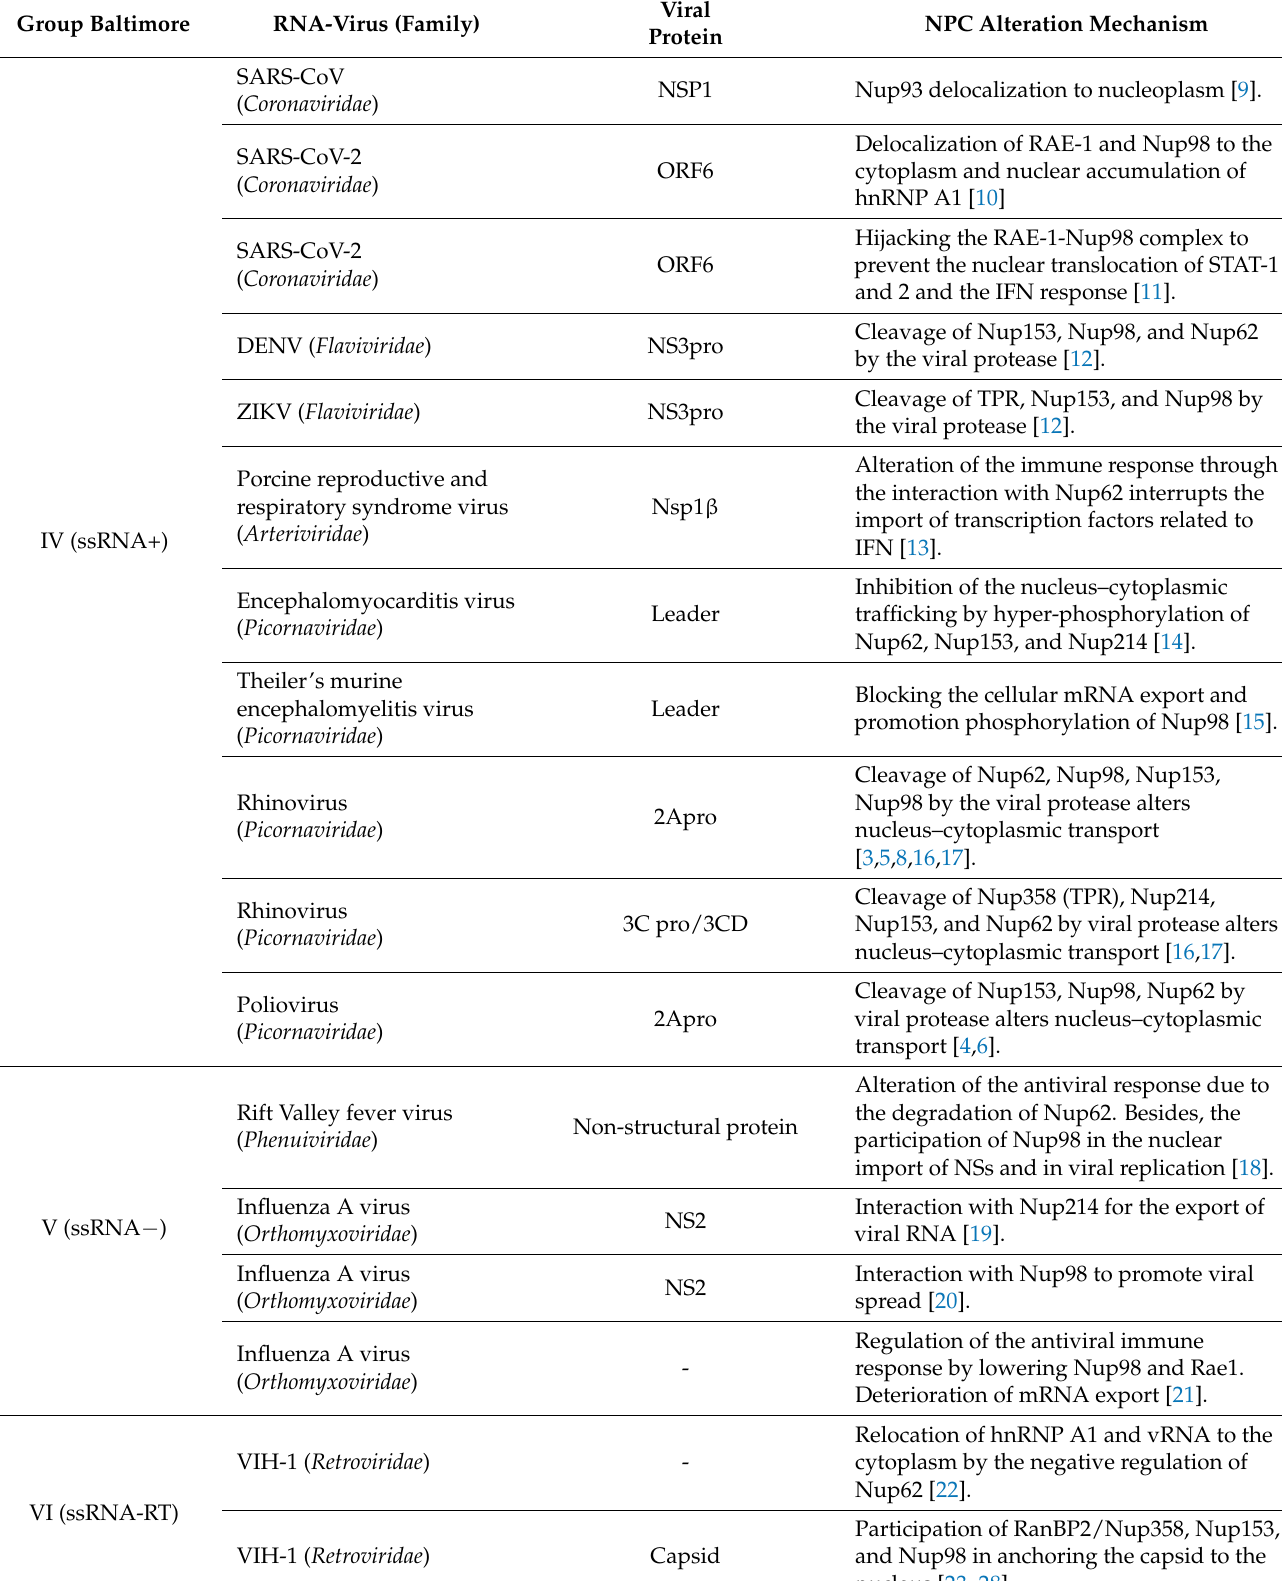
Table 1. Mechanisms of positive-strand RNA viruses to affect the nucleus–cytoplasmic